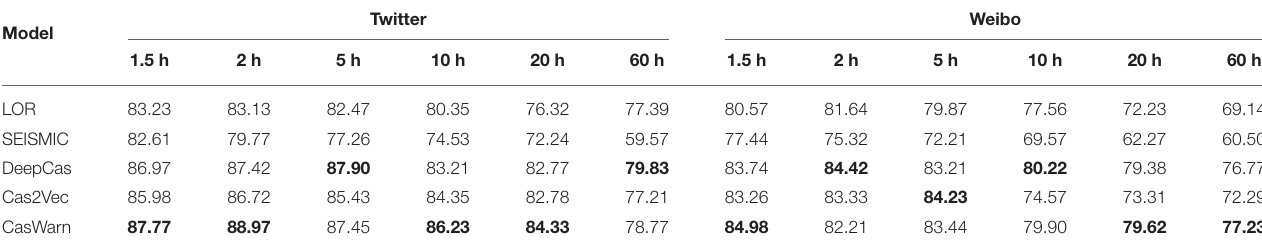
TABLE 2 | Prediction performance of different models on the two datasets (%).